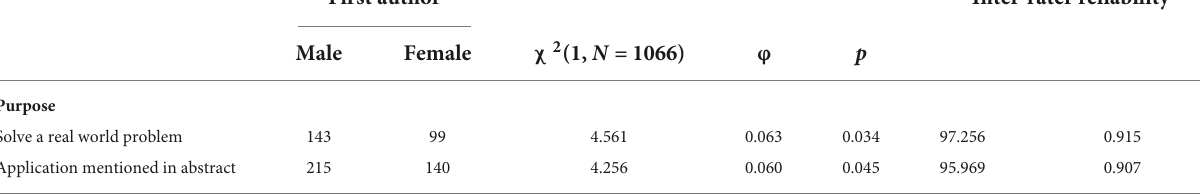
TABLE 2 Number of papers with male and female lead authors across